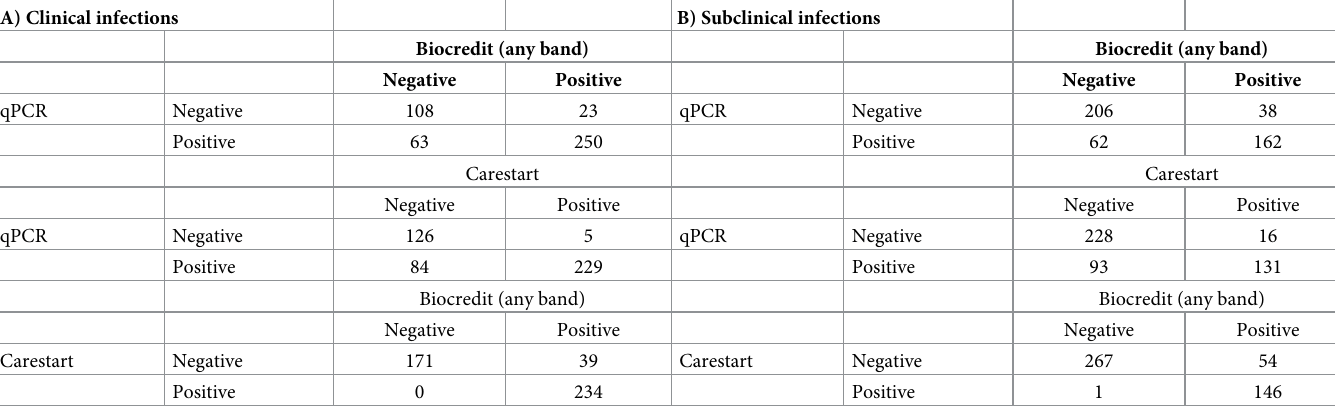
Table 3. Number of positives by RDT vs. qPCR, and by Biocredit vs. CareStart. A) Clinical